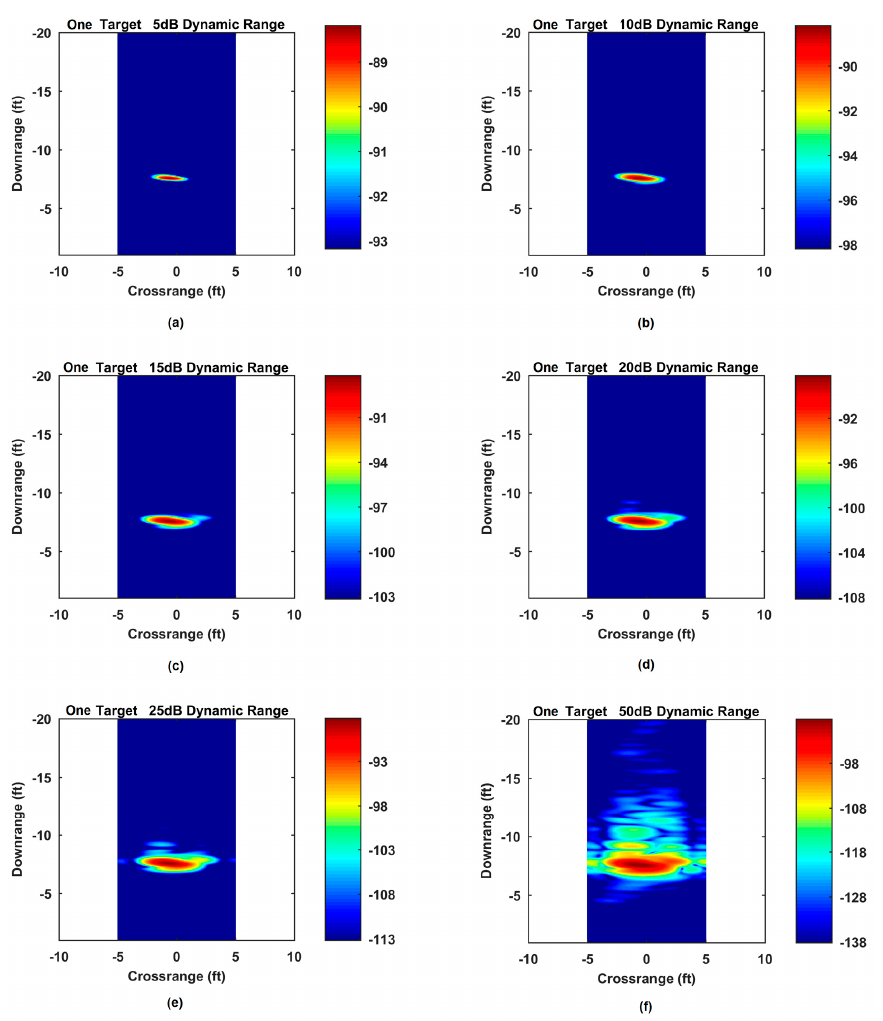
Figure 19. Images of a single target 2.13 m (7 feet) down-range over 5–50 dB image dynamic range using wavelet-SVD: ( a ) 5 dB; ( b ) 10 dB; ( c ) 15 dB; ( d ) 20 dB; ( e ) 25 dB; ( f ) 50 dB.